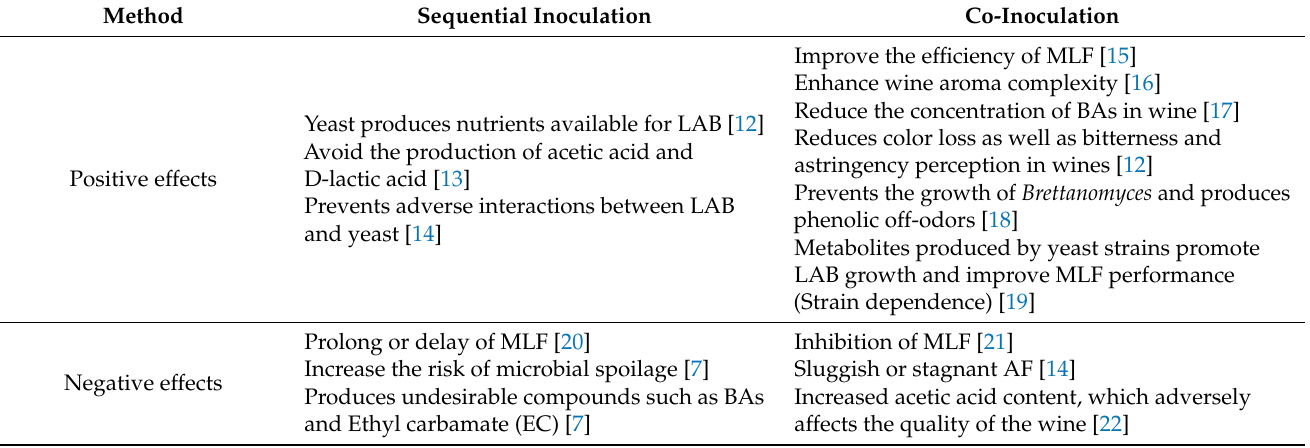
Table 1. Comparison of the strategies of sequential inoculation and Co-inoculation to improve for MLF. Method